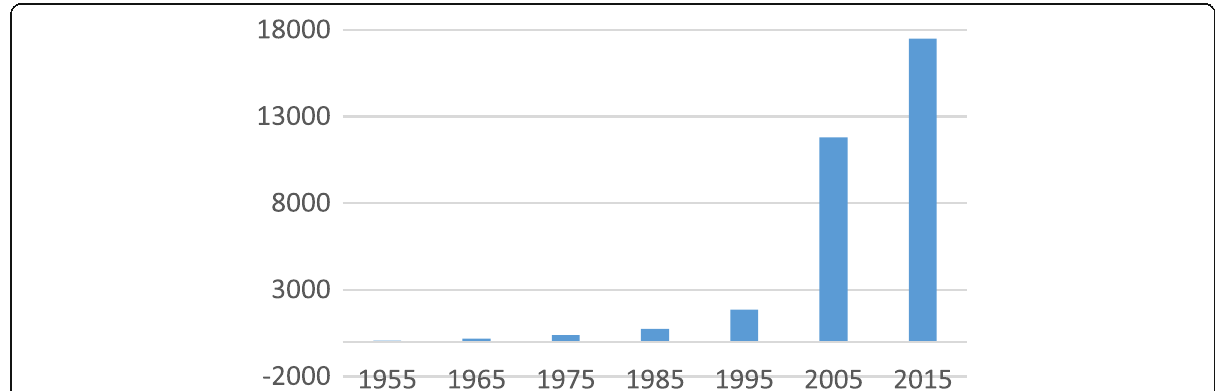
Fig. 1 Number of papers listed by Google scholar for 10 year periods since 1945 using “ plant AND antimicrobial OR antibiotic OR antibacterial OR antifungal ” as search